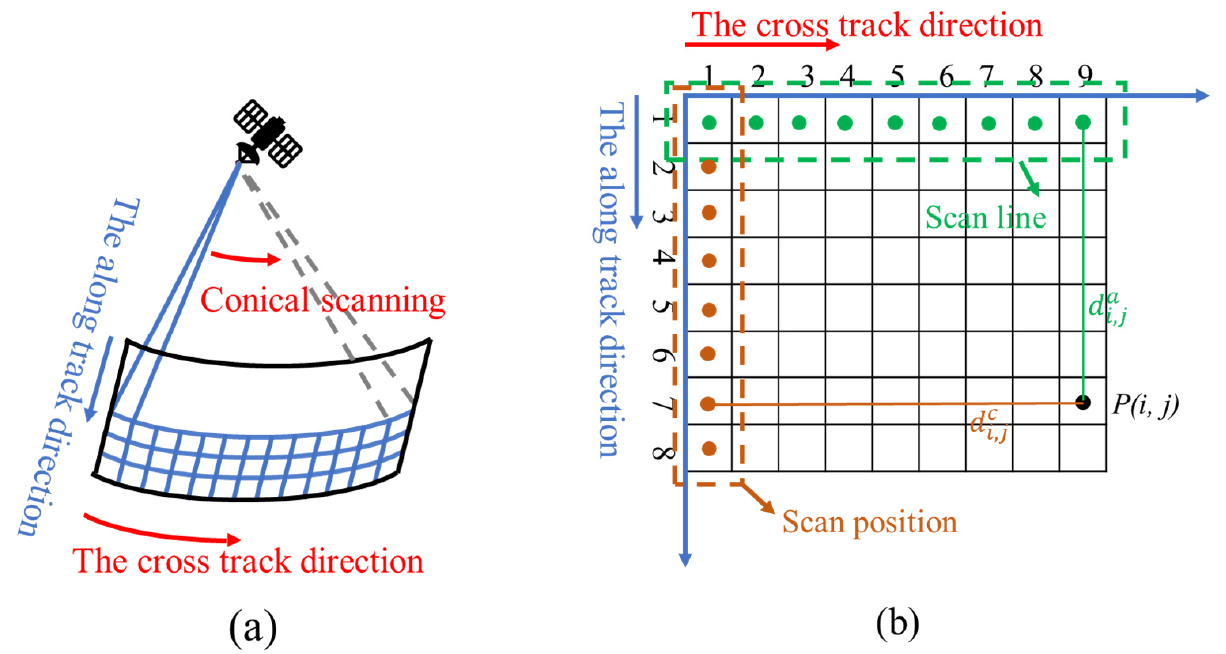
Figure 5. Conical scanning geometry of the MWRI instrument. ( a ) shows the scanning schematic of the FY ‐ 3D MWRI. ( b ) shows the schematic of FY ‐ 3D MWRI brightness temperature images. The red arrow points to the cross ‐ track direction. The blue arrow points to the along ‐ track direction.